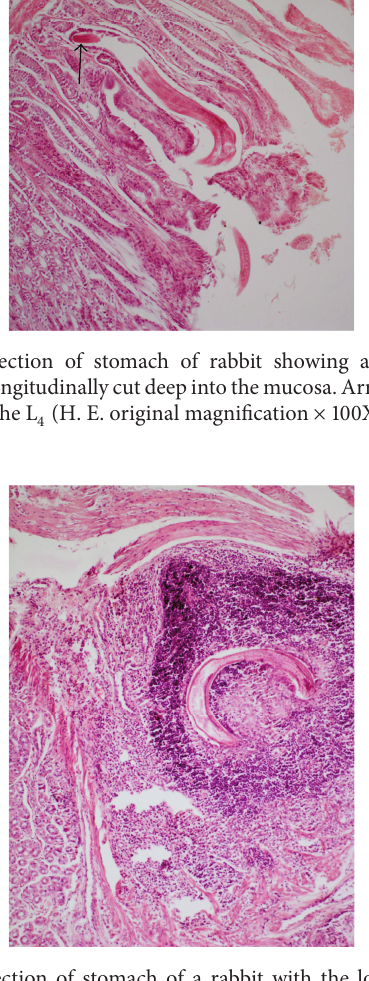
Figure 5: Parasitic granuloma in the tunica muscularis of stomach with chronic inflammatory cells including fibroblasts and cut sec- tions of P. sexalatus surrounded by an adjacent zone of necrosis (H. E. original magnification ×